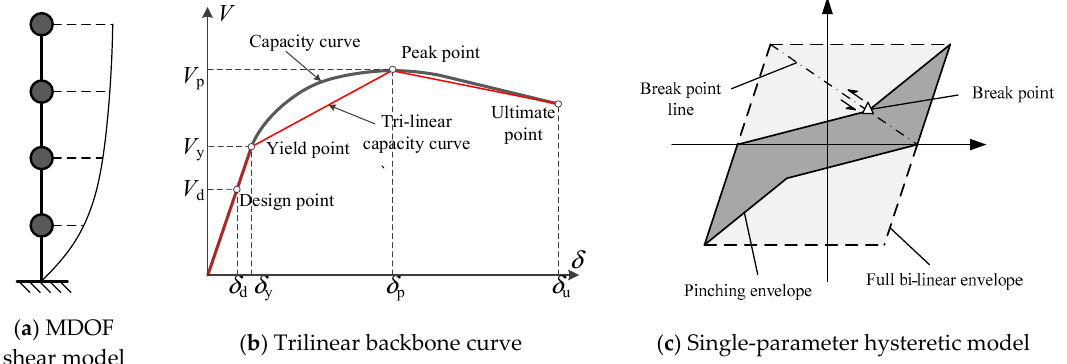
Figure 2. Multi-degree-of-freedom (MDOF) shear model: ( a ) MDOF shear model; ( b ) Trilinear backbone curve; ( c ) Single-parameter hysteretic model.